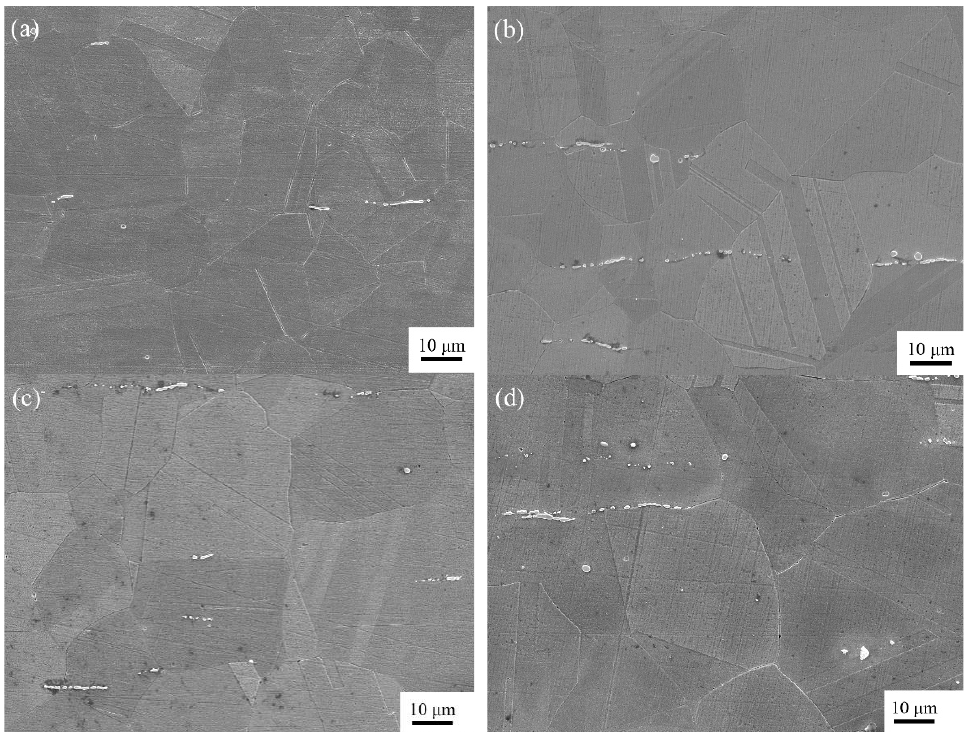
Figure 3. The microstructure of the Ni-36.6W-15Co sample after annealing for ( a ) 10 min, ( b ) 30 min, ( c ) 60 min and ( d ) 120 min at 1150 °C.